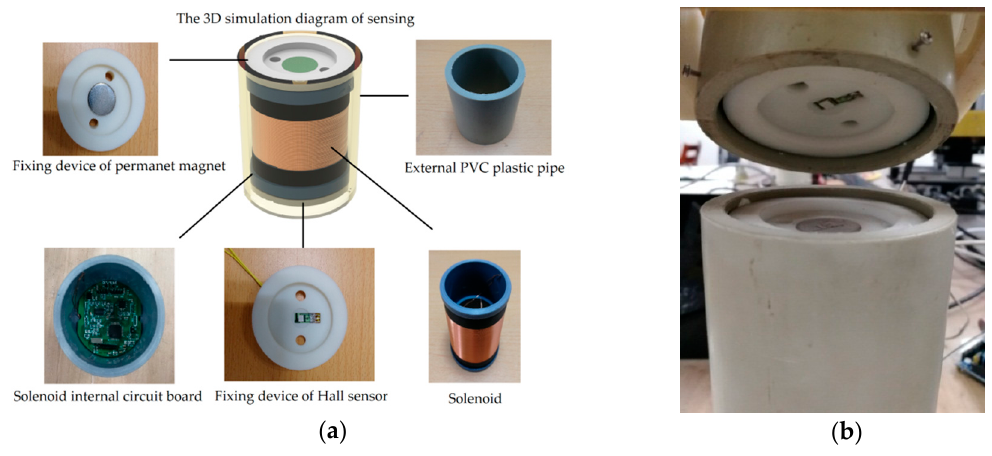
Figure 4. Updating structure design of sensing unit based on 3D printing. ( a ) 3D simulation model of sensing unit structure based on 3D CAD/CAM software and physical figure of each component; ( b ) photograph of device structure.